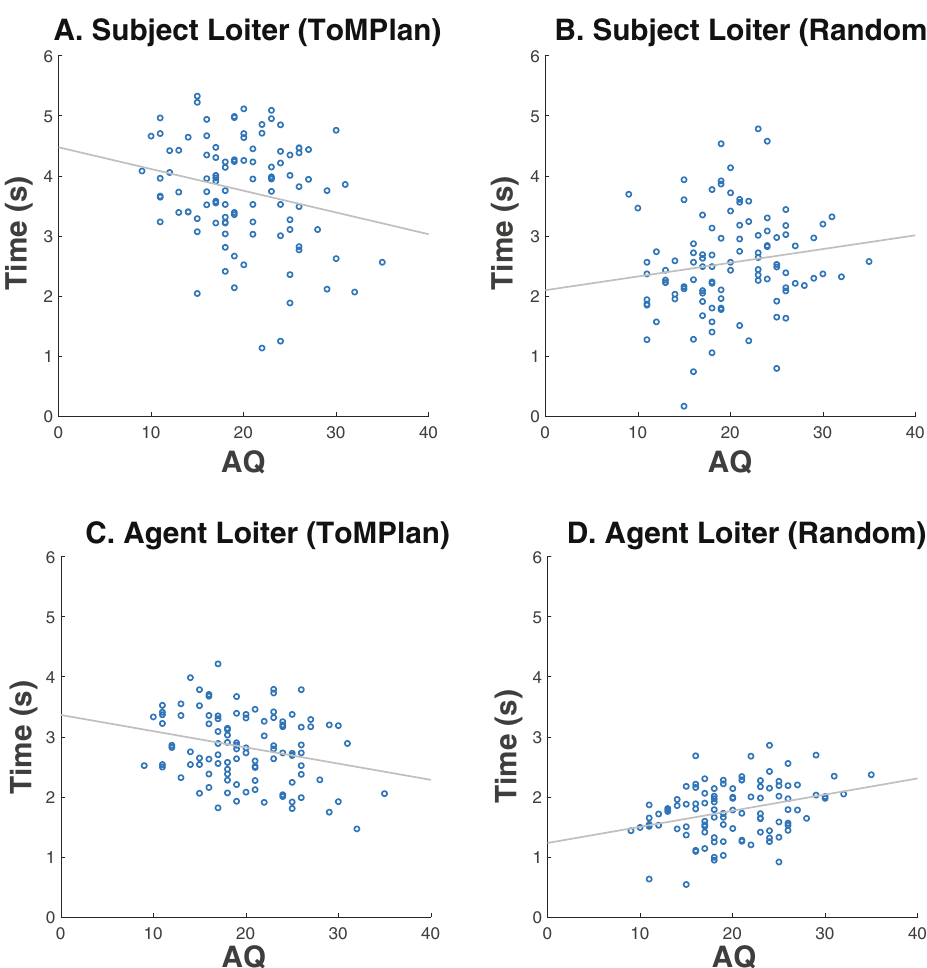
Figure 7. Average time in seconds spent “loitering” as a function of AQ. ( A ) Subject loitering when playing with a ToMPLan agent was significantly correlated with AQ (r = − 0.225, p < 0.01). ( B ) Subject loitering when playing with a Random agent was not significantly correlated with AQ, but showed a positive trend. ( C ) ToMPlan agent loitering was significantly correlated with AQ (r = − 0.255, p < 0.004). ( D ) Random agent loitering was significantly correlated with AQ (r = 0.326, p < 0.001). The x-axis is AQ ranging from 0–40, the y-axis is the average amount of time in seconds the player spent next to a stag per game, and the regression line is